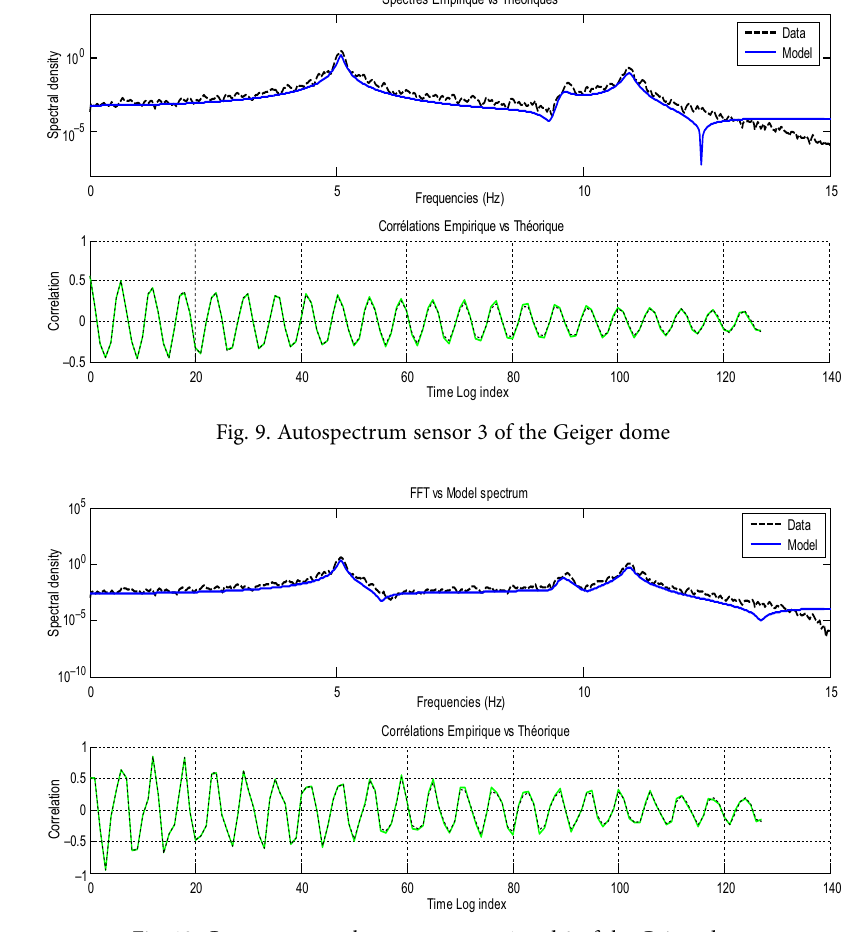
Fig. 10. Cross spectrum between sensors 1 and 3 of the Geiger